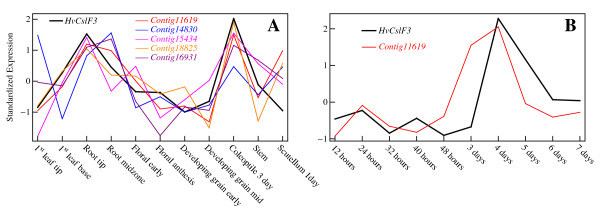
Confirmation of co-expression of HvCslF3 and candidate genes. In panel A the Q-PCR expression profiles of the cellulose synthase-like gene HvCslF3 and the candidate genes identified in this study are compared. Expression profiles have been standardized as described in the text. As can be seen, the genes indeed co-express in the tissues probed in both the Q-PCR and microarray datasets. Panel B shows an additional comparison of Q-PCR coleoptile time course expression profiles of HvCslF3 and Contig11619. The two genes appear to remain roughly co-expressed in this time-course as well.